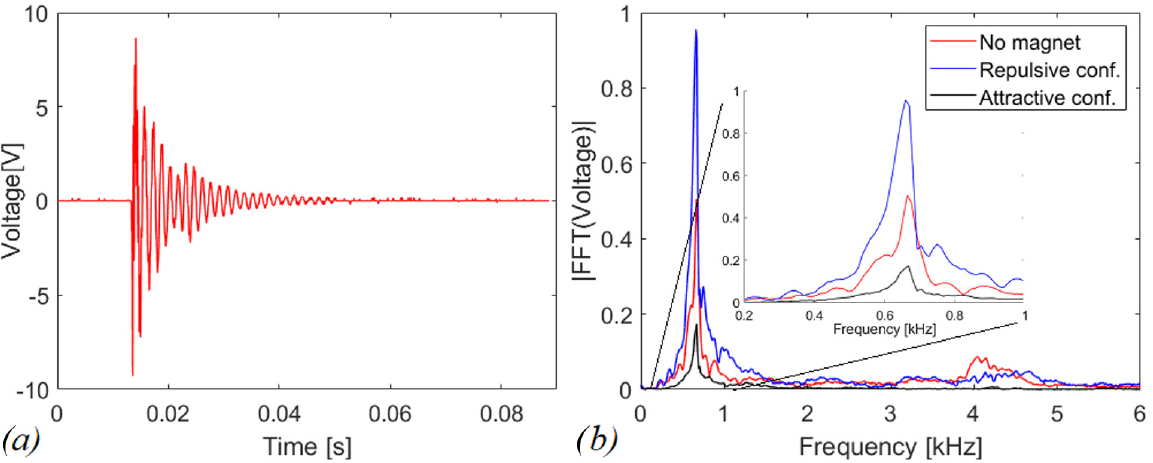
Figure 8. ( a ) Measured voltage across R = 100 k Ω due to free oscillations in case of a single indirect impact in absence of moving mass in the slot. ( b ) FFT responses of the open circuit voltage with a close-up on [0.2,1] kHz.